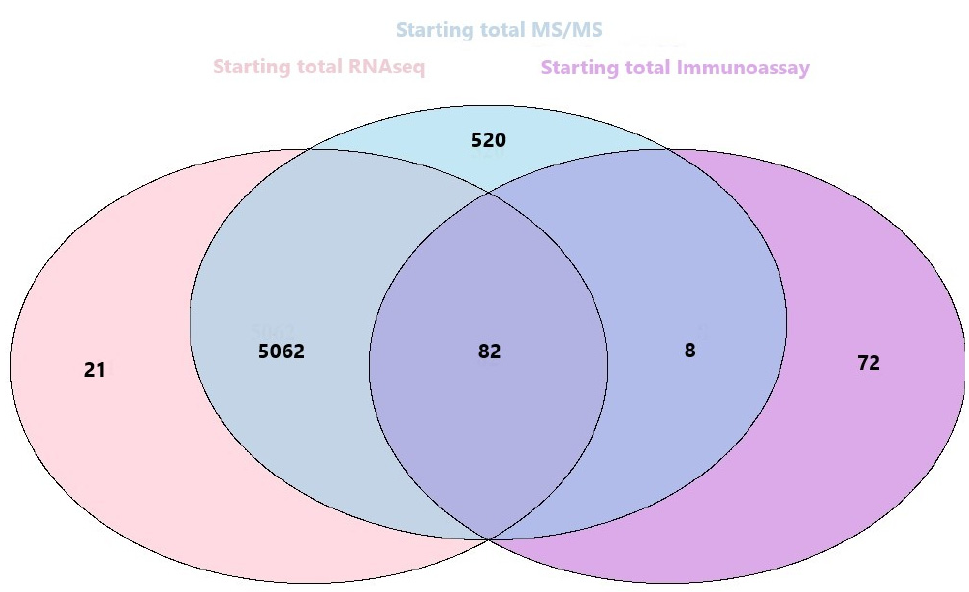
Figure 6. Venn diagram for orthogonal integration among all the datasets from SEC-MAP, LC-MS/MS, RNA-Seq (Number of proteins detected in each dataset).